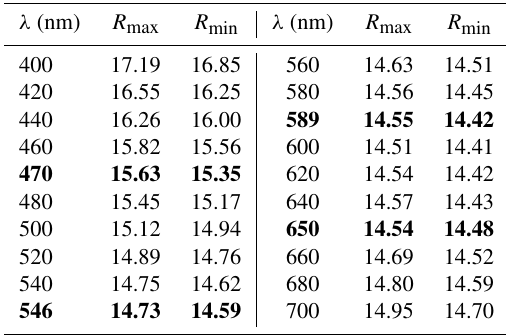
Table 1. Reflectance values for ellinaite from Hatrurim Basin, Israel.